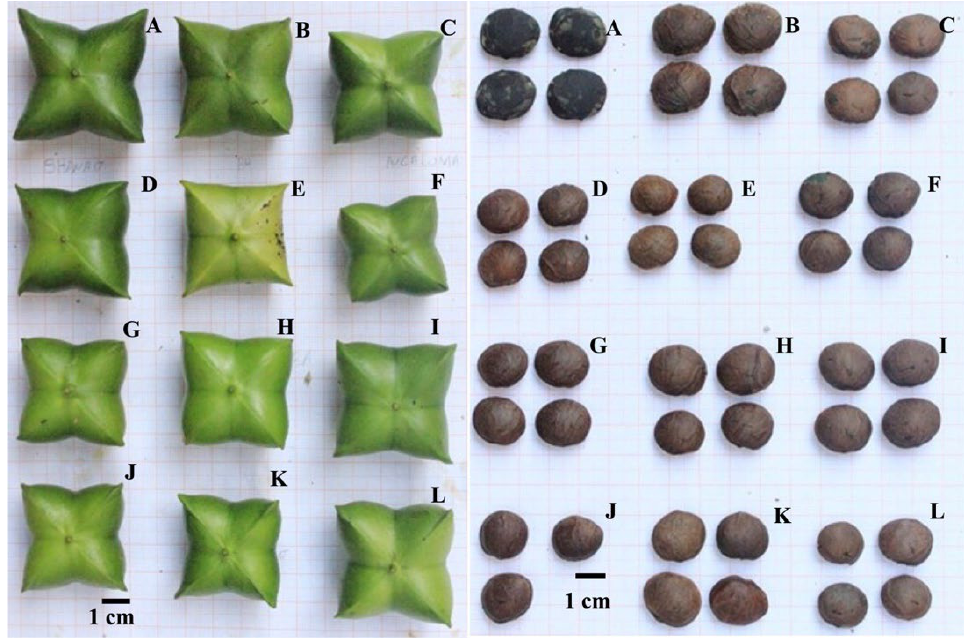
Figure 1. Size of fruits and seeds in 12 sacha-inchi accessions. A—Shanao, B—Novo Horizonte, C—